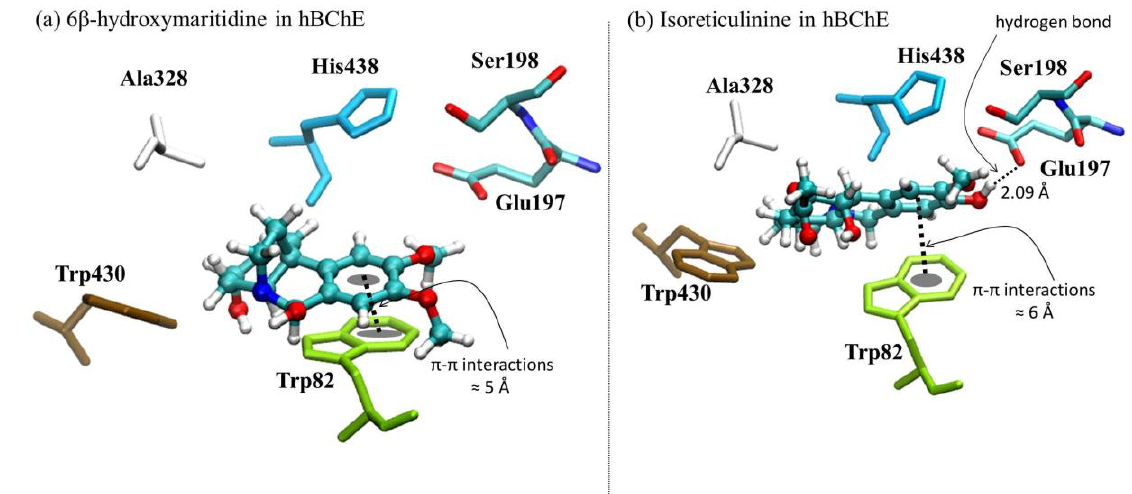
Figure 6. Graphical representations of ( a ) 6β-hydroxymaritidine- h BChE and ( b ) isoreticulinine h BChE complexes. h BChE